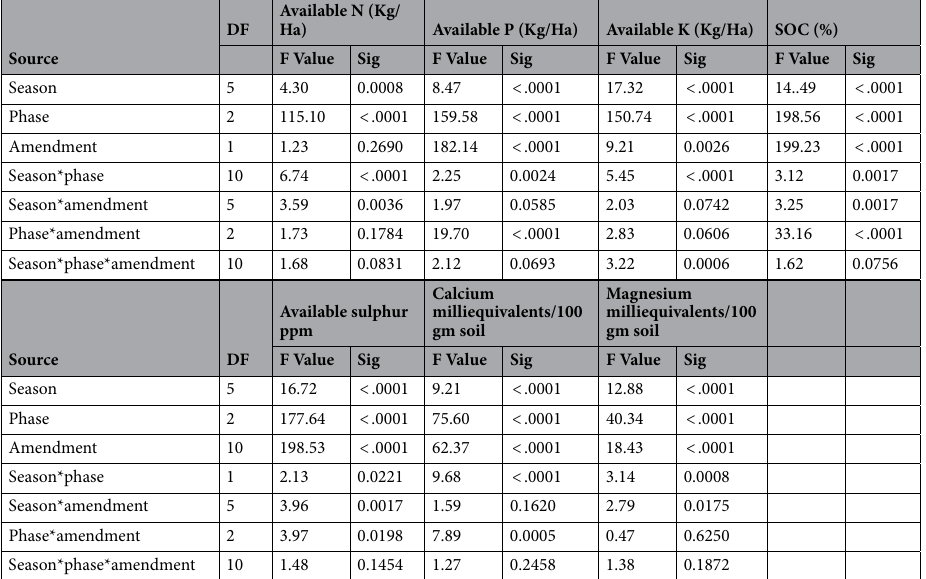
Table 1. The F statistics table for dependent variables available N, P, K and SOC using the GLM